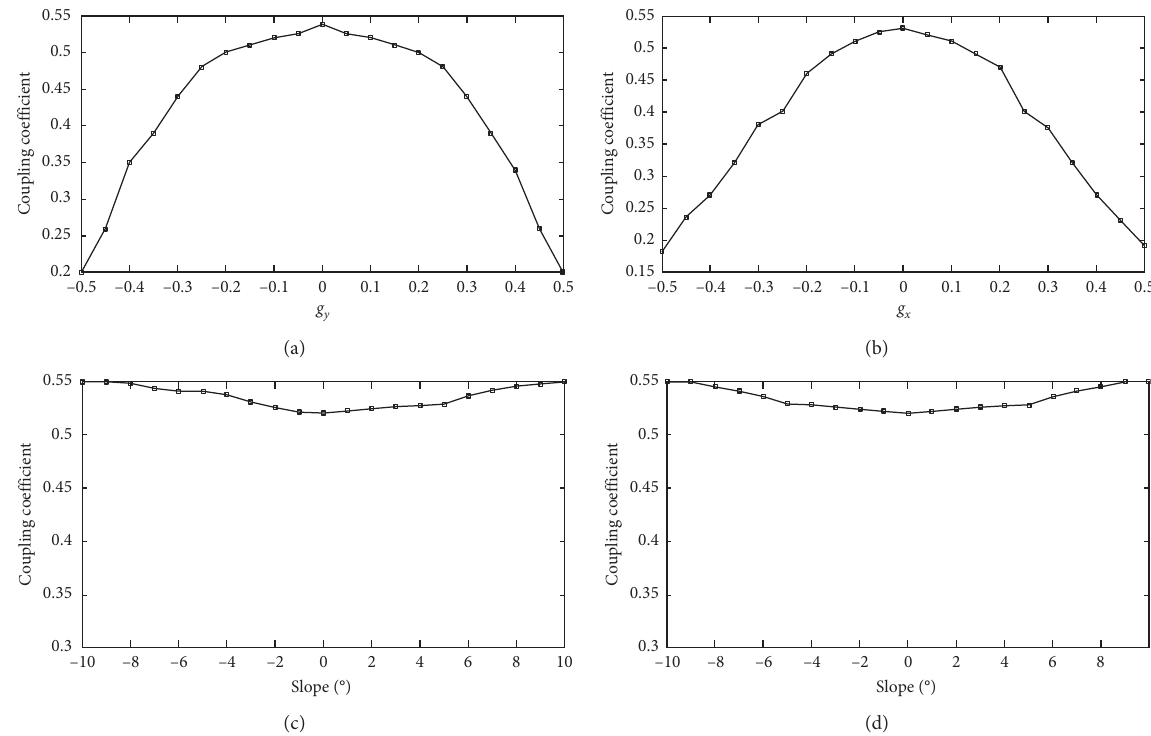
Figure 15: Coupling coefficient under misalignment of secondary coils with spacing of 30mm. (a) Offset along the long side. (b) Offset along the short side. (c) Tilt along the length. (d) Inclined in the width